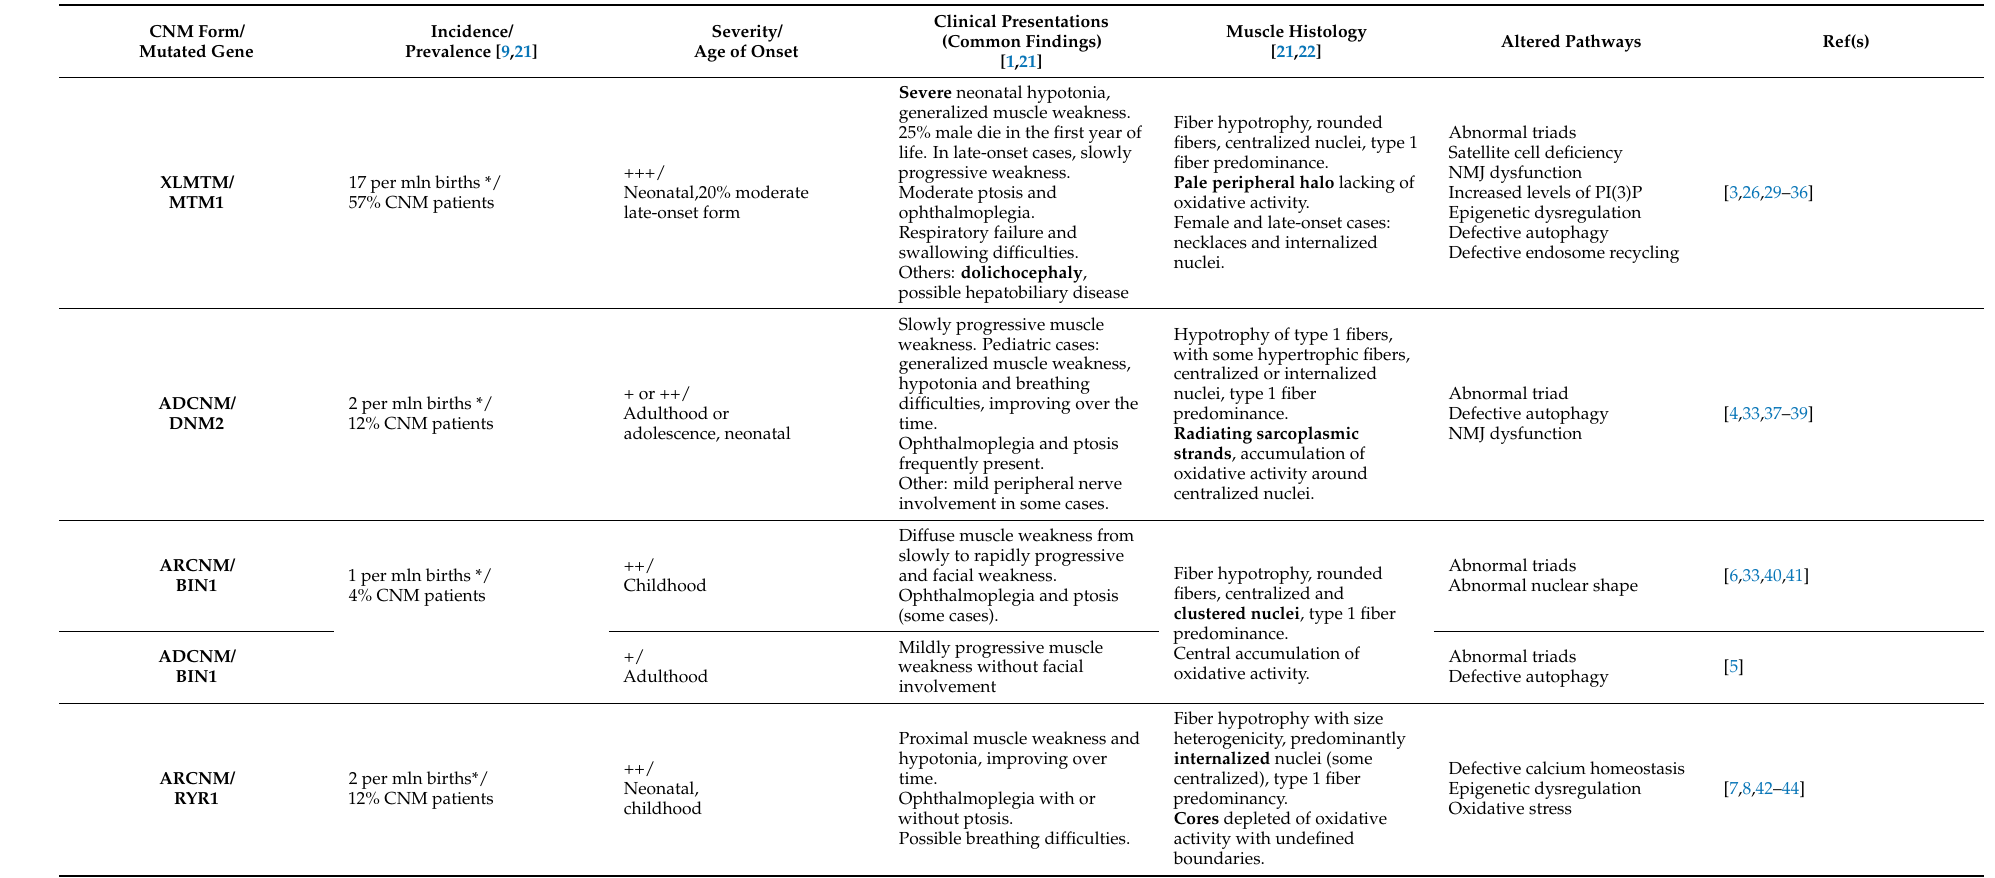
Table 1. Phenotype in patients with MTM1 , BIN1 , DNM2 , or RYR1